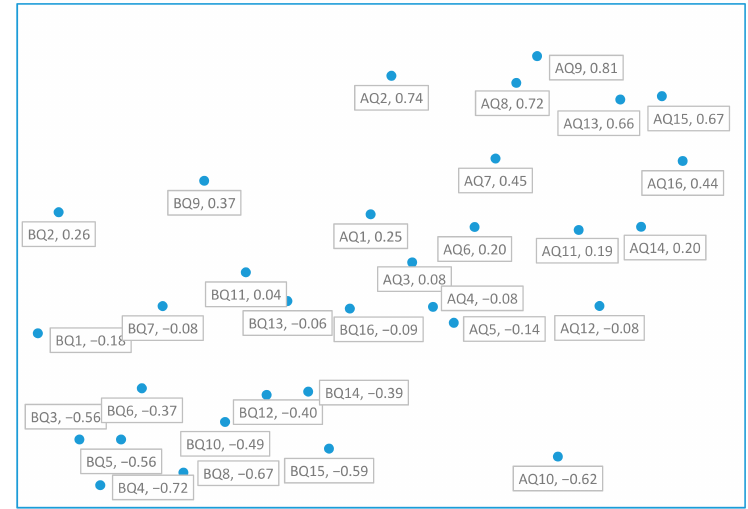
Figure 2. Proximities analysis, (AQ#) means the symptoms with intervention and the (BQ#) means the symptoms without intervention. The distances of every two points mean the similarity between these two symptoms. The longer the distance, the less similar they are, where # means that the numbers ranged from 1 to 16. Meanwhile, ( • Q1) represents of crying spells, ( • Q2) self-loathing, ( • Q3) irritability, ( • Q4) sleep disturbance, ( • Q5) appetite change, ( • Q6) unexplained aches and pains, ( • Q7) feeling nervousness, ( • Q8)feelingfatigue andlossofinterestindailyactivities, ( • Q9)decreaseinfeelingjoy, ( • Q10)feelingdecline in memory, ( • Q11) feeling short of attention, ( • Q12) slowing down of thought, ( • Q13) loss confidence, ( • Q14) pessimism comforting with delusion, ( • Q15) feeling hopeless, and ( • Q16) sickness with fever, vomiting, or diarrhea, where “ • ” can be either A (with intervention) or B (without intervention).